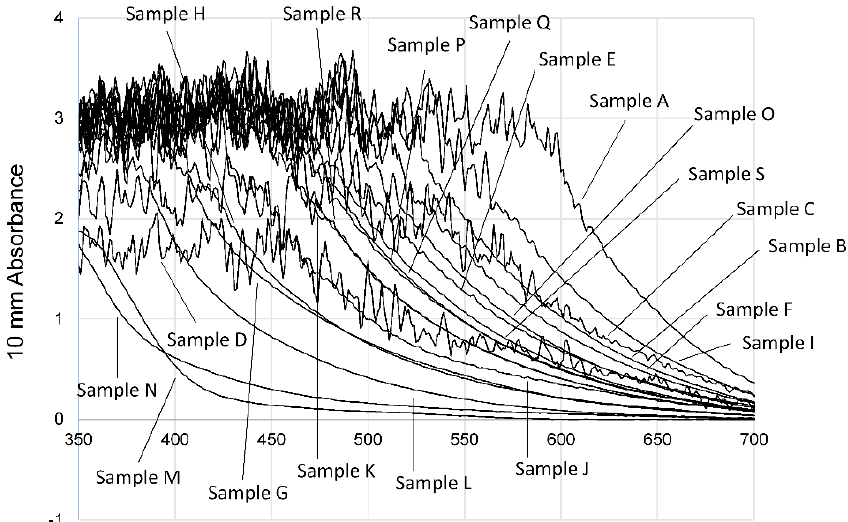
Figure 1. Absorbance of 19 commercial liquid dressings. Absorbance of the 19 commercial liquid